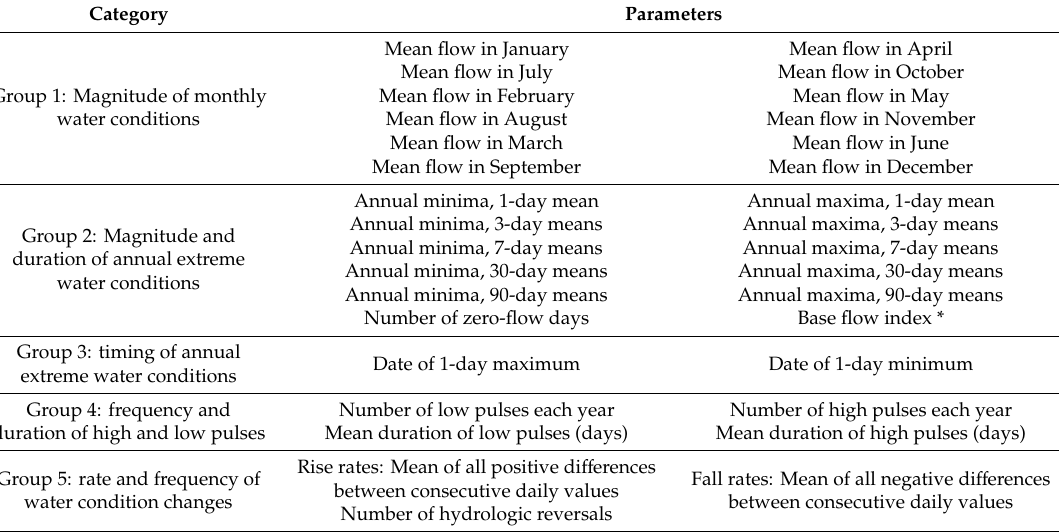
Table 2. Thirty-three Parameters of the indicators of hydrologic